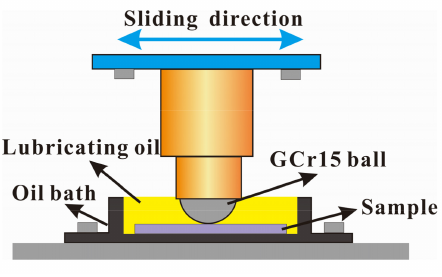
Figure 3. The illustration of the